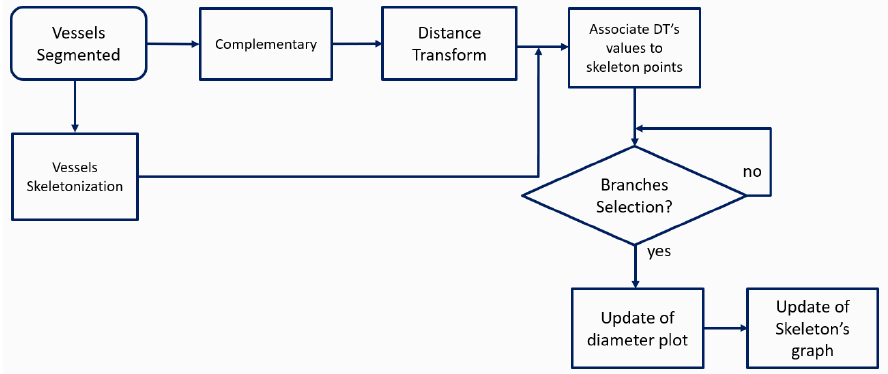
Figure 4. Flow chart of the proposed vessel analysis